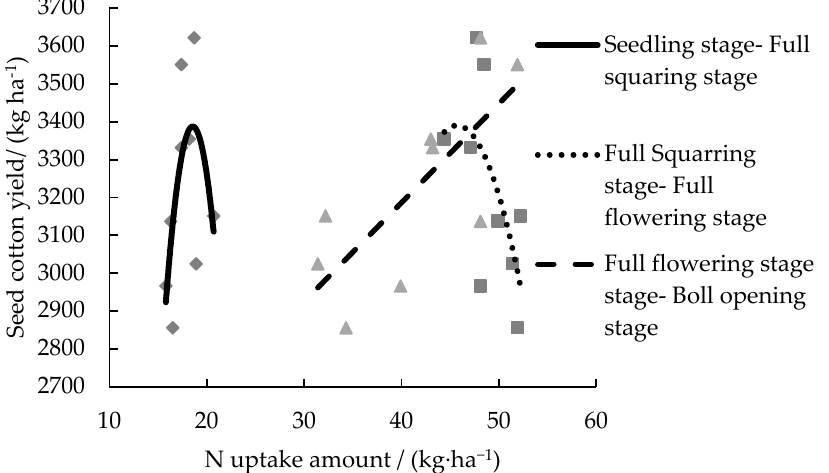
Figure 2. Relationships between seed cotton yield and N accumulations at different growth stages.